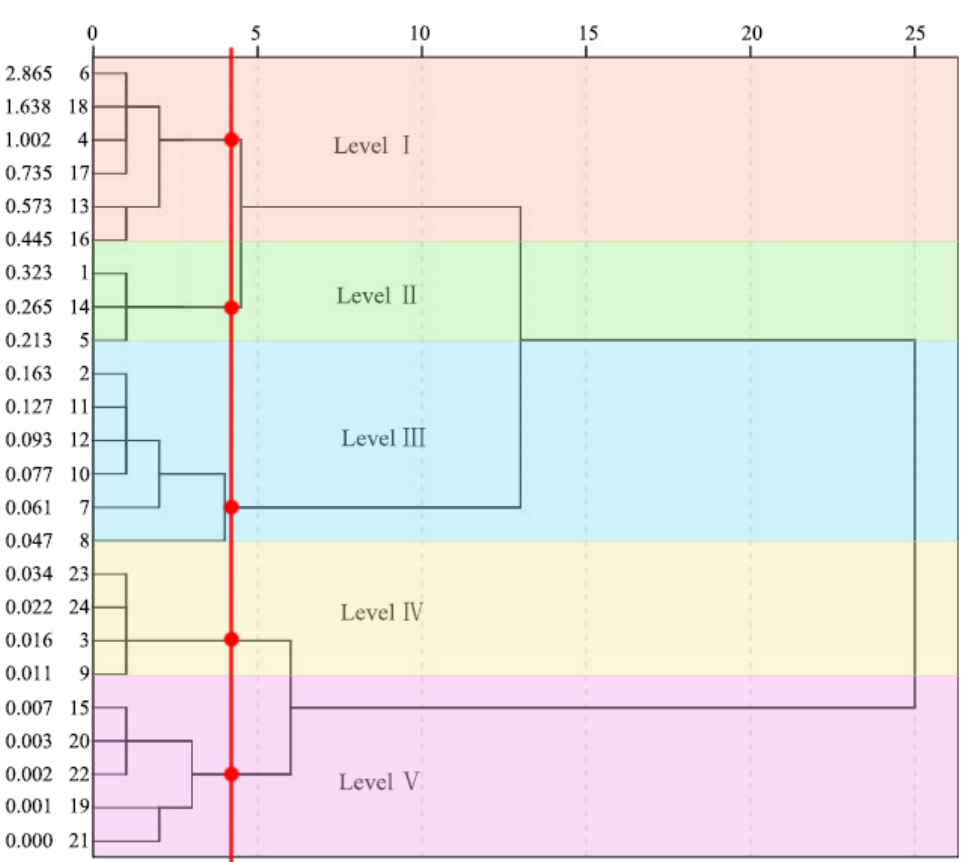
Figure 4. Results of system cluster analysis—tree diagram. Table 3. Criteria for the forest comprehensive healthcare index (FCHI) grades.